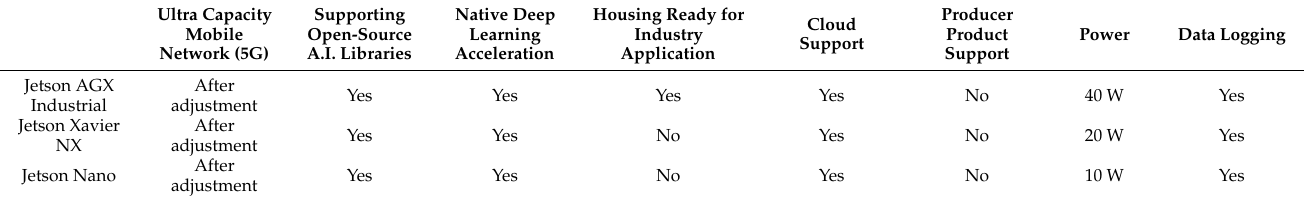
Table 3. Selected devices from an AI perspective for